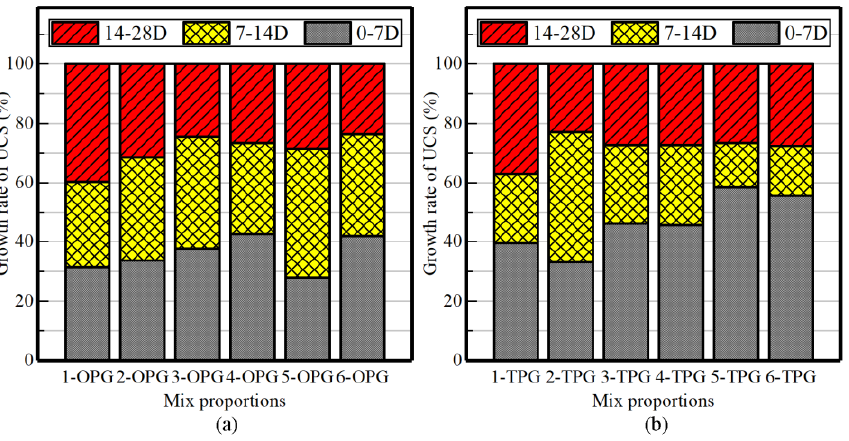
Figure 11. Growth rate ratio of UCS values of ( a ) OCPB, and ( b ) TCPB at different ages.